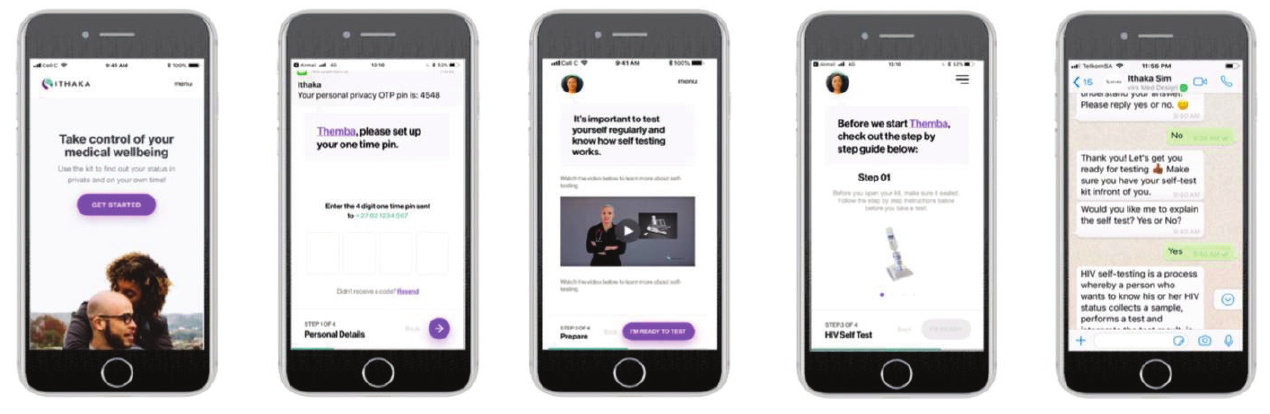
FIGURE 1 : Ithaka